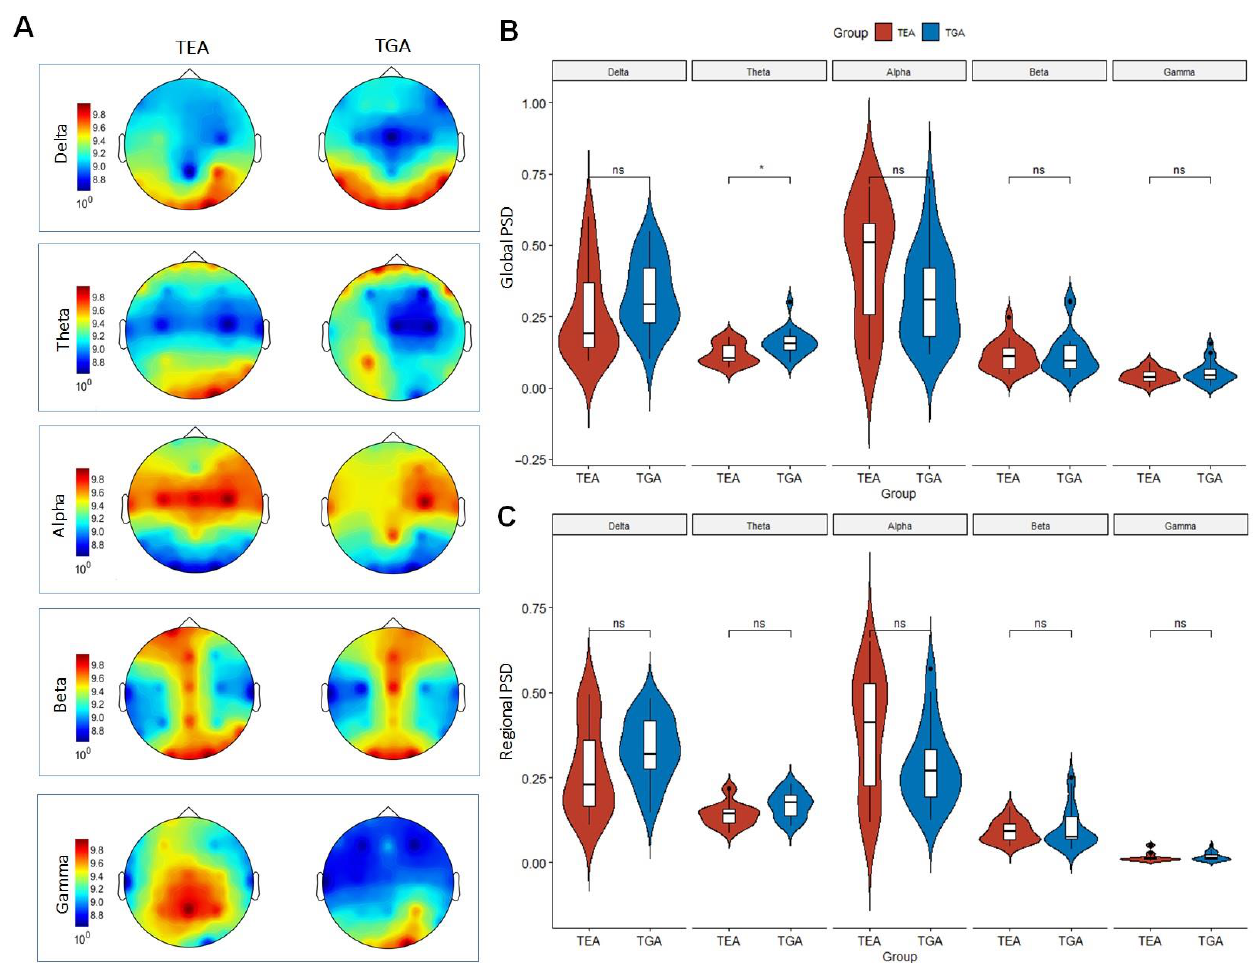
Figure 2. ( A ) Scalp distribution of PSD of TEA and TGA patients for each frequency band (Delta, Theta, Alpha, Beta and Gamma). ( B ) Violin plots show the distribution of relative power in TEA and TGA for each frequency band for Global PSD. ( C ) Violin plots show the distribution of relative power in TEA and TGA for each frequency band for Regional PSD. ns (not statistically significant), PSD (power spectral density), TEA (Transient Epileptic Amnesia), TGA (Transient Global Amnesia), * ( p < 0.05).